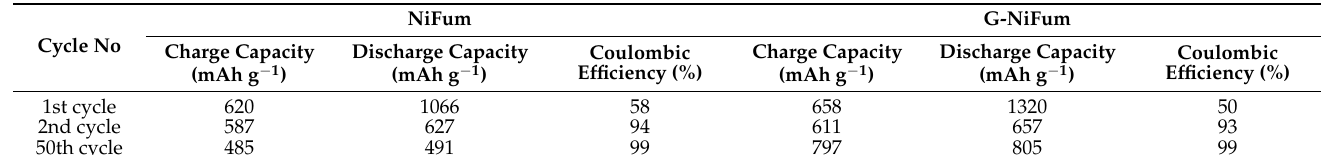
Table 1. Comparison of capacities obtained for 1st, 2nd, and 60th cycles of NiFum and G-NiFum at a current density of 60 mA g − 1 .